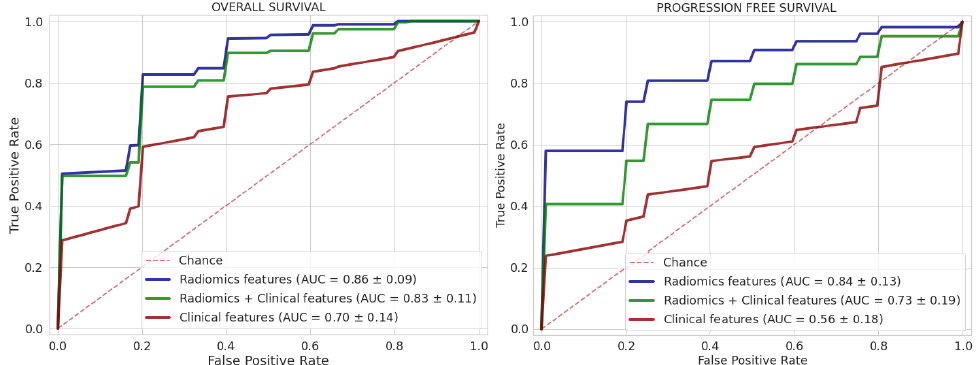
Figure 4. Roc curves of the best classifiers for each feature category: only radiomics features in blue, radiomics + clinical features in green and only clinical features in red (currently